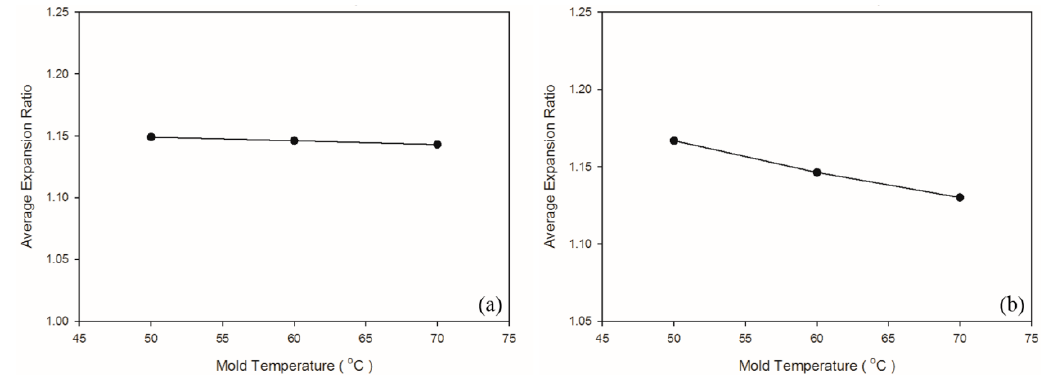
Figure 13. Expansion ratios at various mold temperatures: ( a ) PP matrix and AC CBA; ( b ) PS matrix and AC CBA. Table 9. Microscopic effects of mold temperature on the PP and PS cells as observed through the SEM.